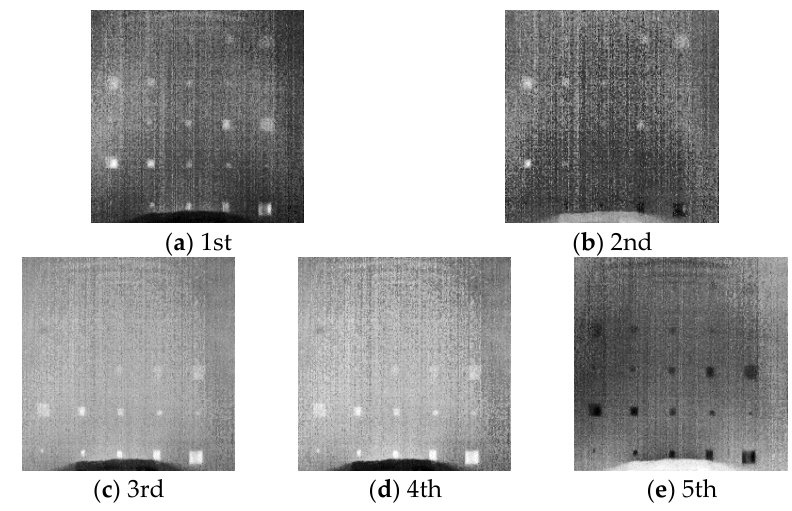
Figure 7. SAE images obtained through the proposed SAE–PT approach.